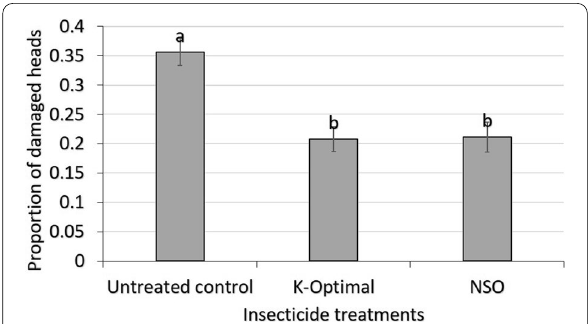
Fig. 4 Mean proportion of sorghum heads damaged by insect pests under different insecticide treatments. Note: Data are means standard error of means (S.E.M); NSO ± Bars with different letters are significantly different at 5%